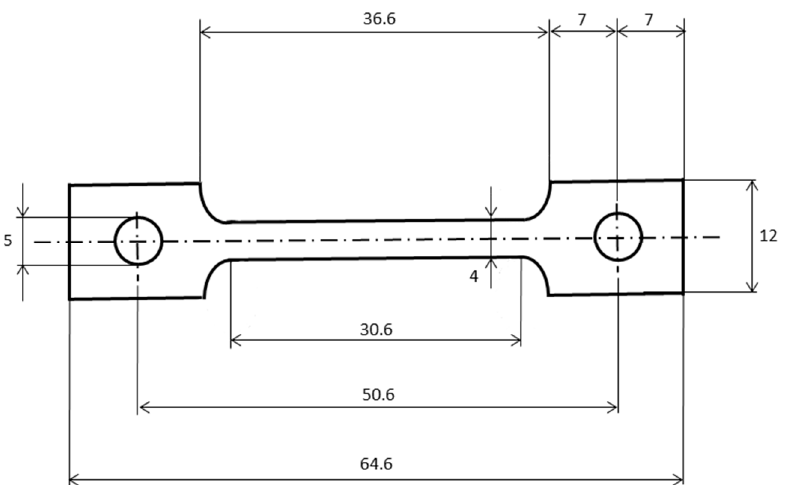
Figure 1. Schematic drawing of a typical probe used in tensile tests (dimensions are expressed in millimeters.